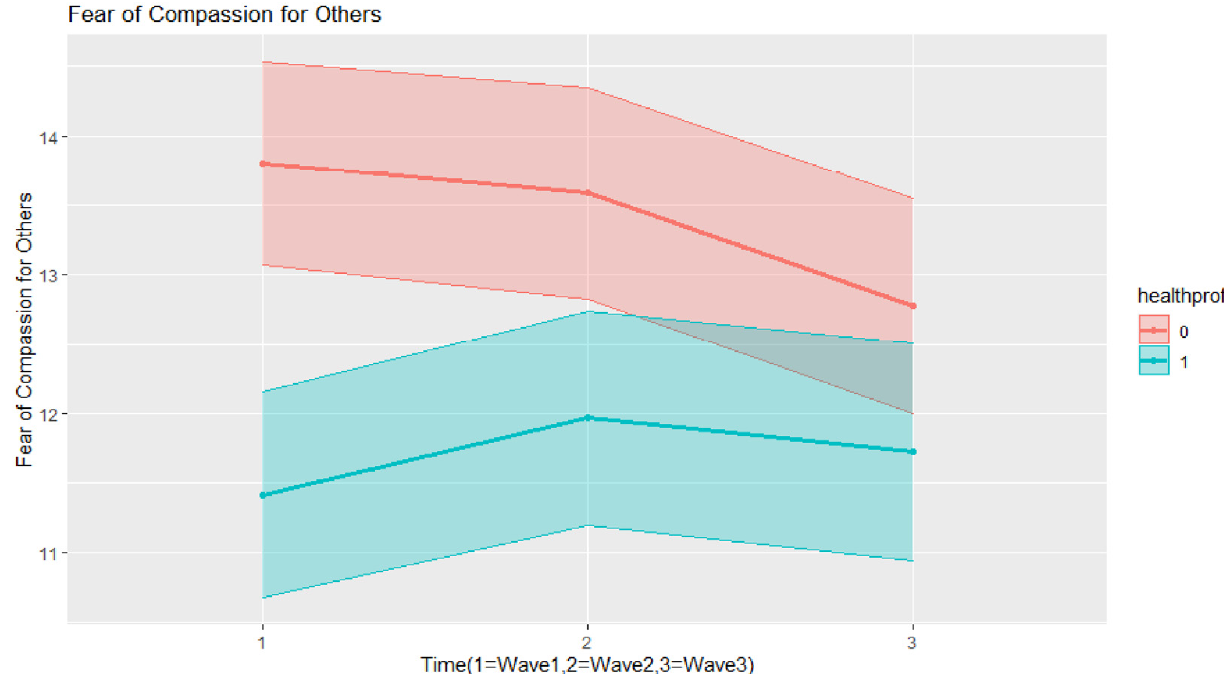
Figure 2. Interaction effects in the final model for fears of compassion for others. Table 6. Estimates of the final model for fear of compassion for